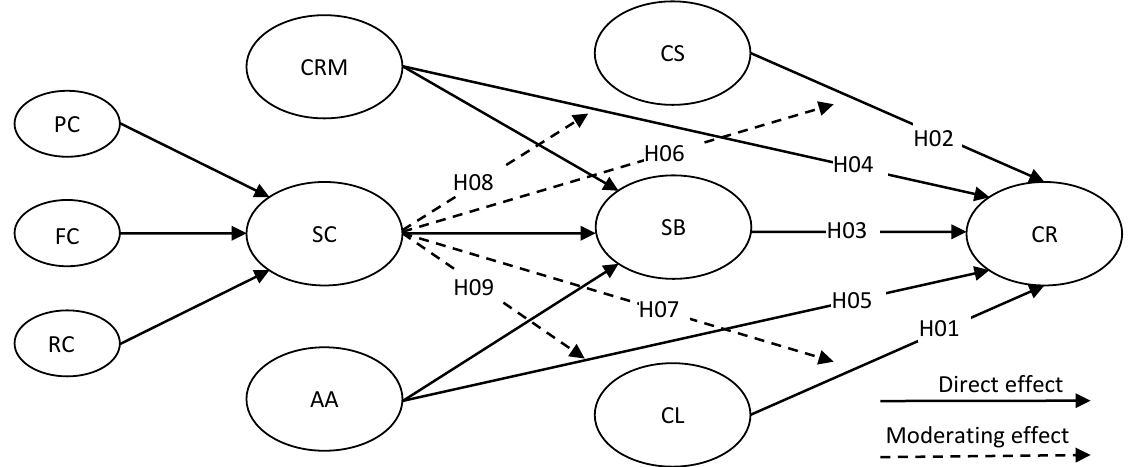
Moderating effect